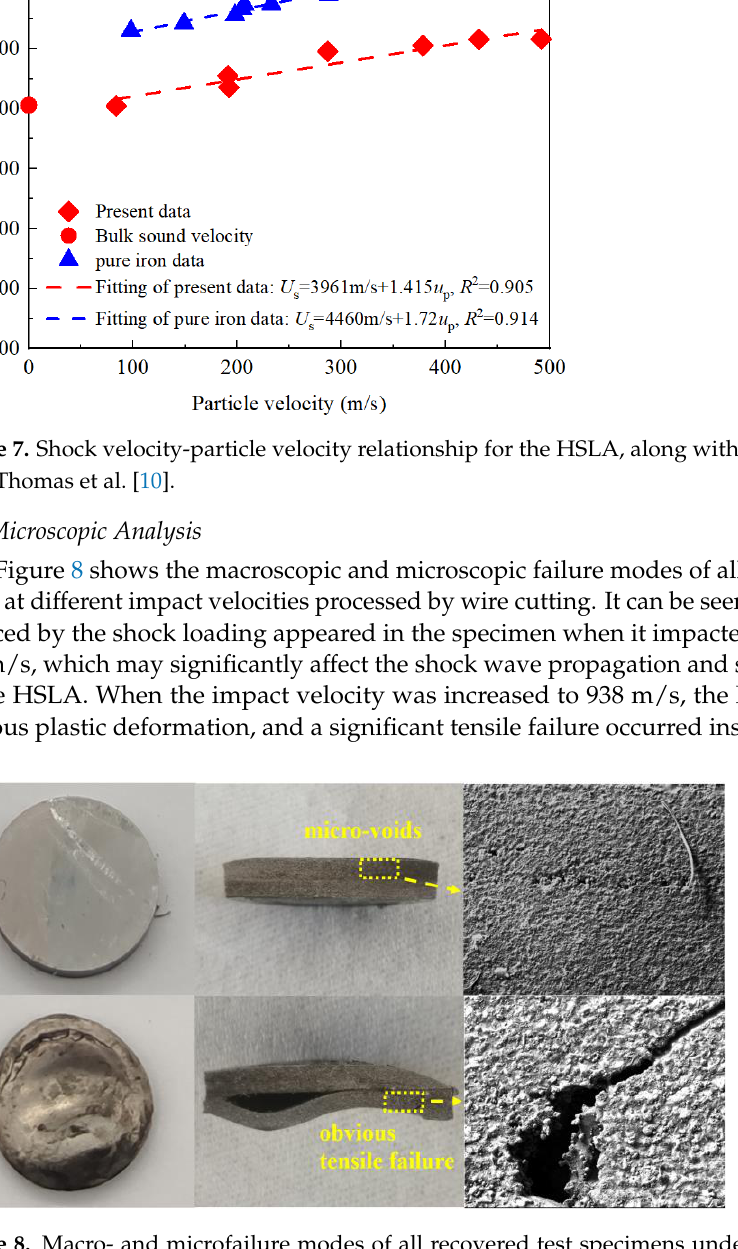
Figure 8. Macro- and microfailure modes of all recovered test specimens under different impact velocities.